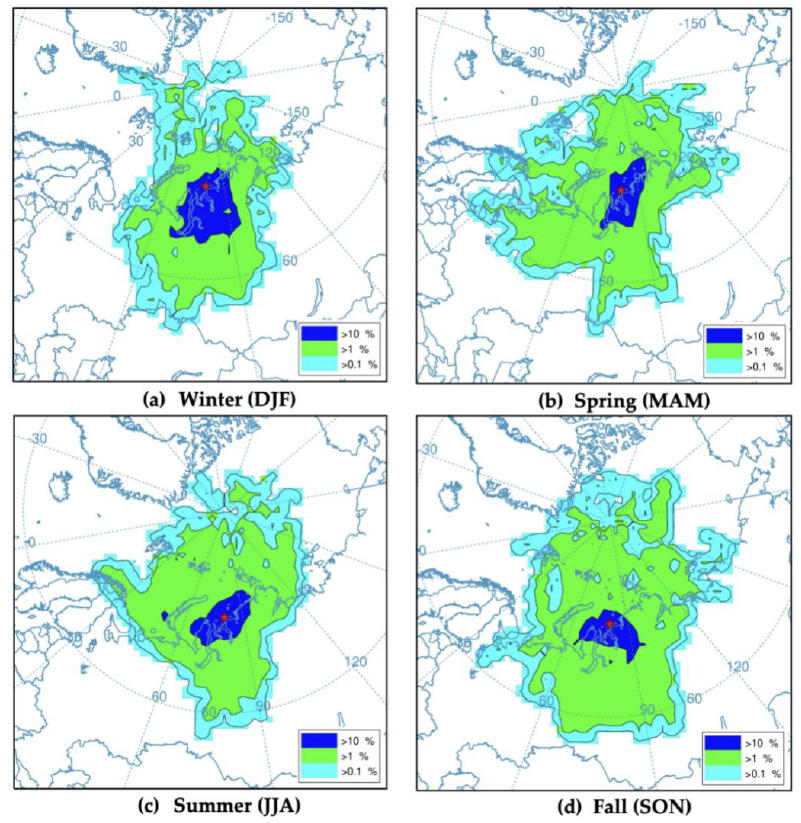
Figure 8. Backward trajectory frequency analysis of air parcels moving into the study area based on the ARL NOAA HYSPLIT model with the NCEP/NCAR Reanalysis driving meteorological fields.